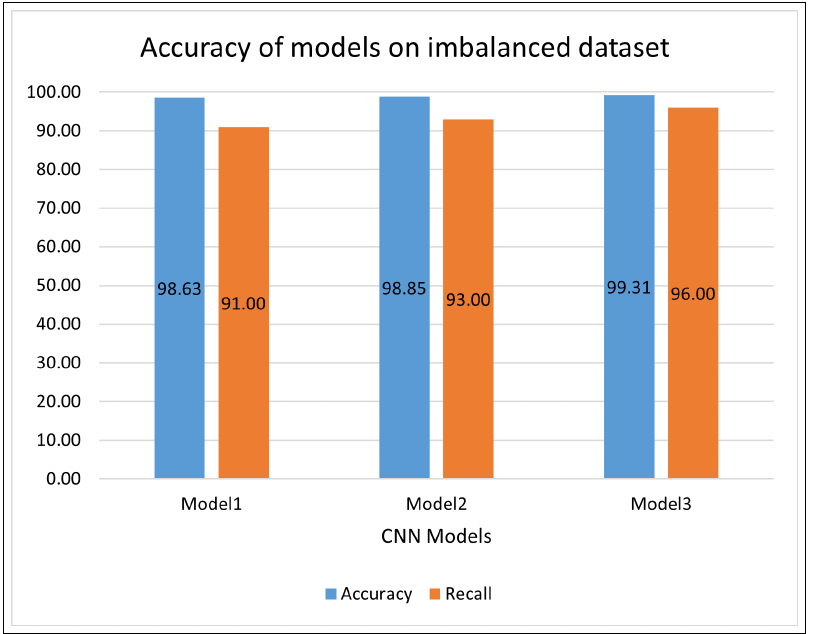
Figure 8. Accuracy of models on the data